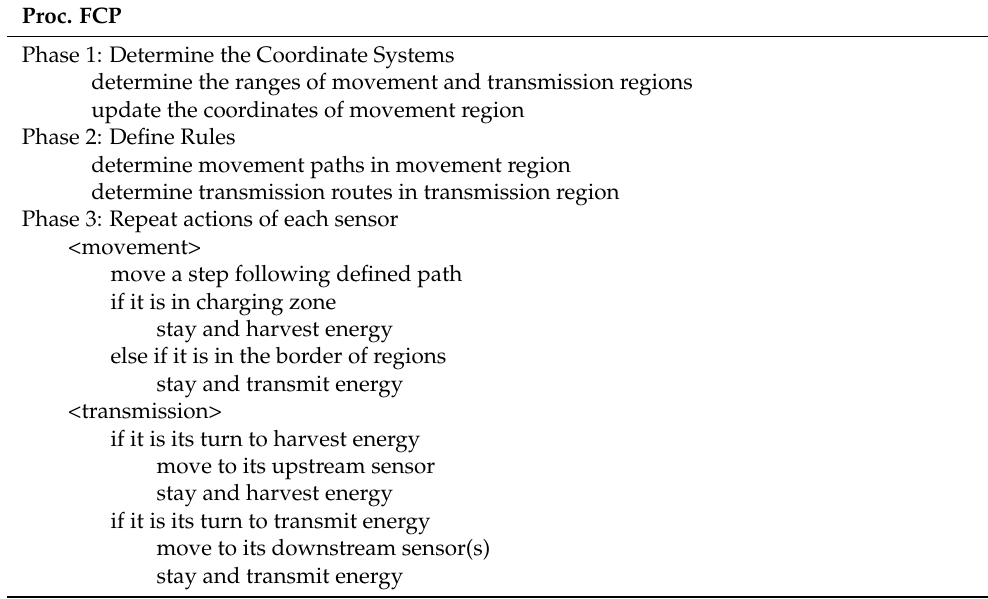
Table 1. Pseudocode for the FCP. Proc.